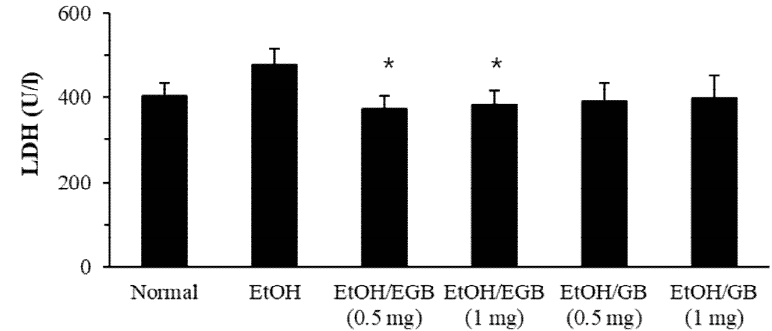
Figure 4. Effect of EGB on the level of serum lactate dehydrogenase (LDH) in AILD. The serum LDH level was measured using serum specimens collected 1 day after the final administration of EtOH. * p < 0.05, compared with the EtOH-fed group.